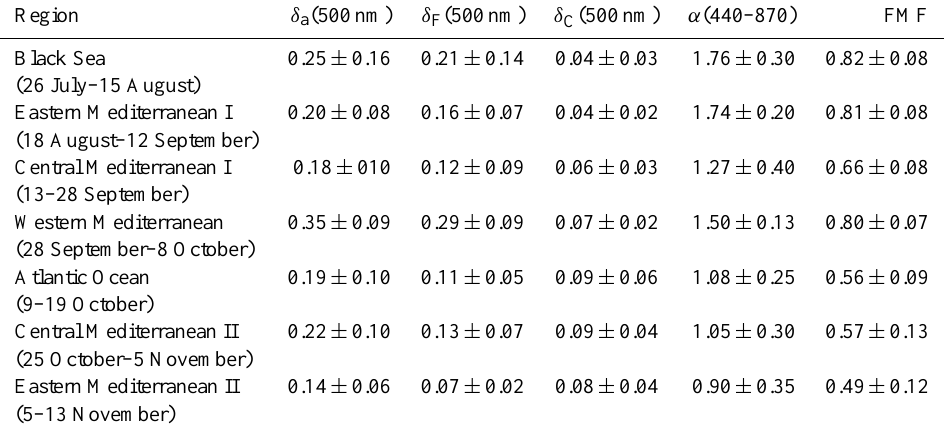
Table 3. Mean values of δ a (500nm), δ F (500nm), δ C (500nm), α (440–870) and FMF obtained over the Black Sea; the western, central and eastern Mediterranean Sea; and the Atlantic Ocean during the Nautilus ship cruise from 26 July to 13 November